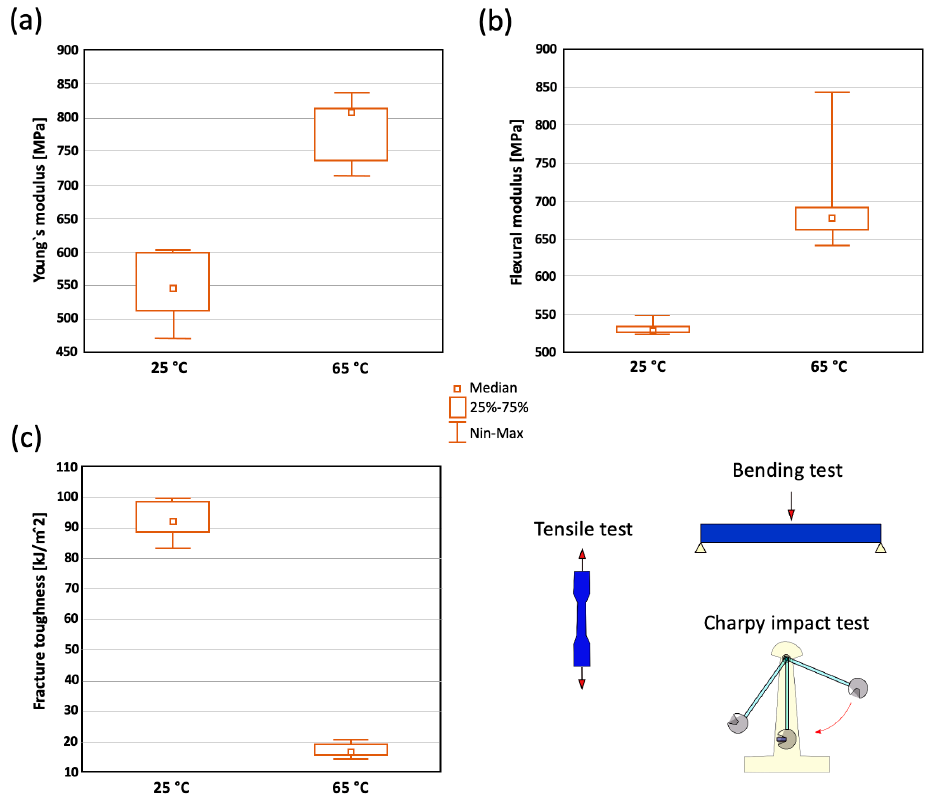
Figure 7. Boxplots illustrating the mechanical properties of the 25 °C and 65 °C samples; tensile modulus − ( a ), flexural modulus − ( b ) and fracture toughness − ( c ).